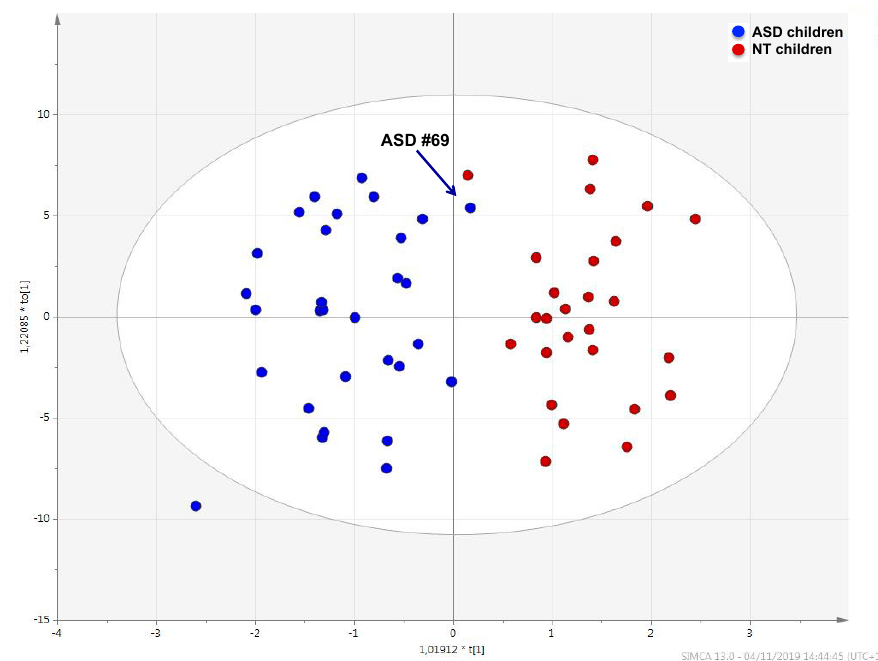
Figure 1. OPLS-DA score plot showing the metabolic profile of ASD children (blue dots) and that of typically developing children (red dots). Black arrow indicates the metabolome of ASD child #69. Sample #69, marked in the plot by an arrow, fell within the metabolic cluster of NT children.